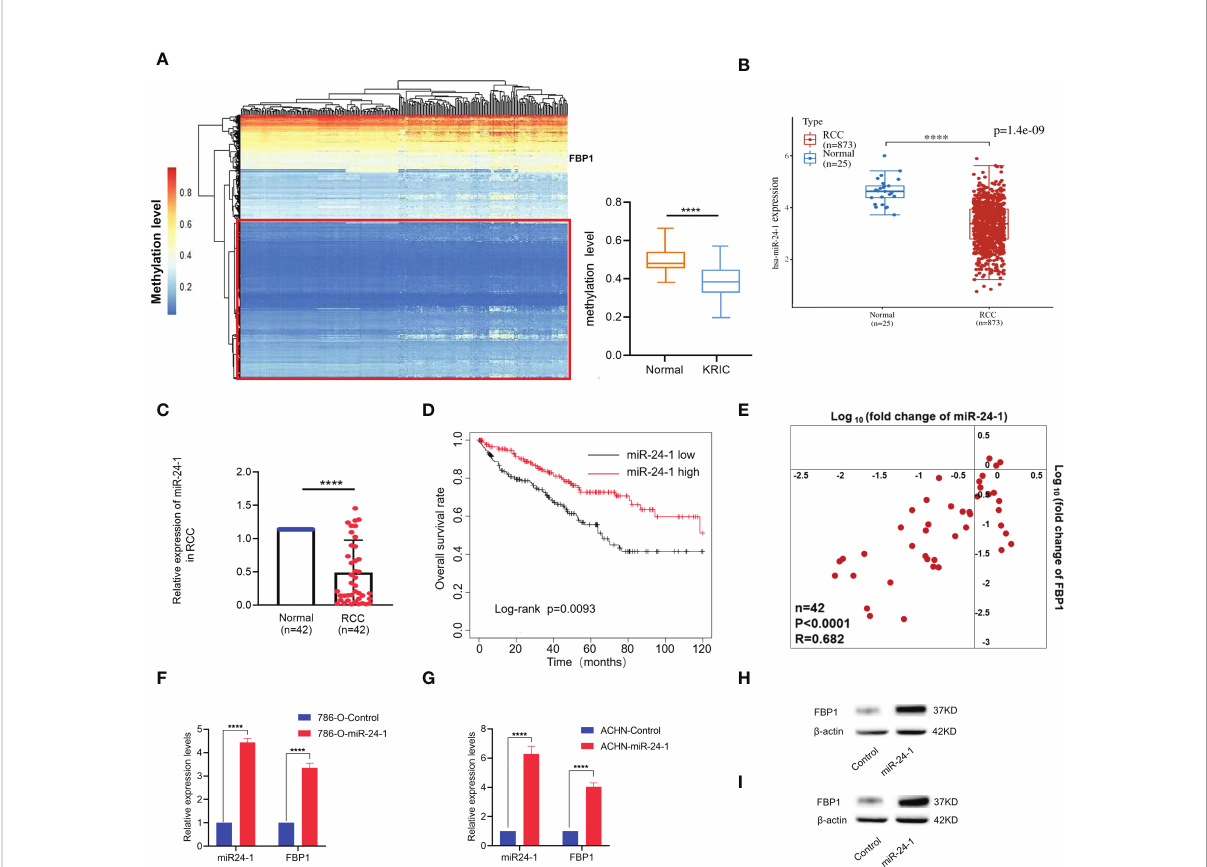
FIGURE 2 Tumor suppressor gene FBP1 can be activated by miR-24-1 in RCC cells. (A) Left panel: DNA methylation pro fi ling for downregulated tumor suppressor genes in RCC, reporting the depletion of FBP1 in RCC was not caused by hypermethylation in promoter; Right panel: the methylation level of FBP1 promoter between normal and KIRC ones. (B) The expression levels of miR-24-1 in RCC and adjacent normal renal tissues from TCGA database by bioinformatic analysis. (C) The expression levels of miR-24-1 in RCC and adjacent normal renal tissues detected by qPCR. (D) Kaplan – Meier survival analysis showed miR-24-1 is signi fi cantly associated with poor overall survival in RCC patients with low expression of miR-24-1 (n=166) compared to high expression of miR-24-1 (n=265). (E) Both miR-24-1 and FBP1 are downregulated in RCC compared to normal ones. Besides, the expression levels of miR-24-1 and FBP1 in RCC tissues exhibit a signi fi cantly positive correlation. Correlation coef fi cient = 0.682. (F, G) The activation of FBP1 by miR-24-1 was assessed by qPCR in 786-O (F) and ACHN (G) cells